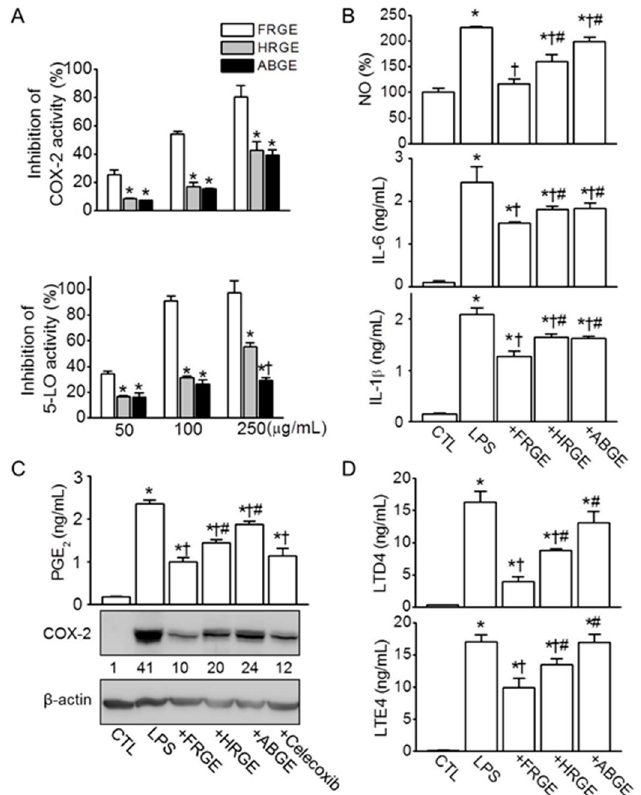
Figure 2. Anti-inflammatory activity of garlic extracts. ( A ) Inhibition of COX-2 and 5-LO activities by garlic extracts. The activities of garlic extracts were measured by calculating absorbance. * p < 0.05 compared with the FRGE treatment. † p < 0.05 compared with the HRGE treatment; ( B ) Inhibitory effects of garlic extracts on the production of NO and the release of pro-inflammatory cytokines (IL-6 and IL-1 β ) in LPS-activated RAW264.7 cells. The cells were pretreated for 2 h with garlic extract (1000 μ g/mL) before stimulation with LPS (1 μ g/mL) for 24 h; ( C , D ) Inhibitory effect of garlic extracts on the LPS-induced PGE 2 secretion and COX-2 expression ( C ) and on the release of LTD4 and LTE4 ( D ). The concentrations of nitrite, IL-6, IL-1 β , PGE2, LTD4, and LTE4 were measured in the collected media. Total protein isolated from the cells was subjected to western blot analysis for COX-2. The numbers below the blot represent the normalized ratio of the expression levels of COX-2 to those of β -actin for each lane. Equal quantities (30 μ g) of total protein were loaded in each lane. β -actin was used as a loading control. * p < 0.05 compared with the control (CTL). † p < 0.05 compared with the LPS treatment. # p < 0.05 compared with the FRGE treatment.